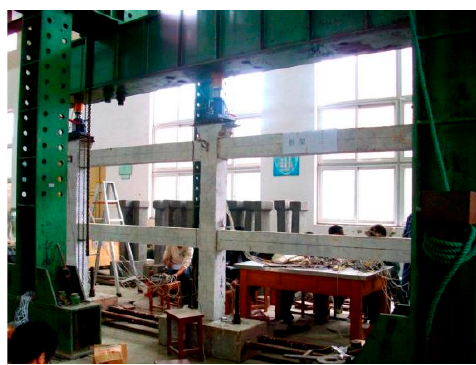
Figure 7. Panorama of framework.